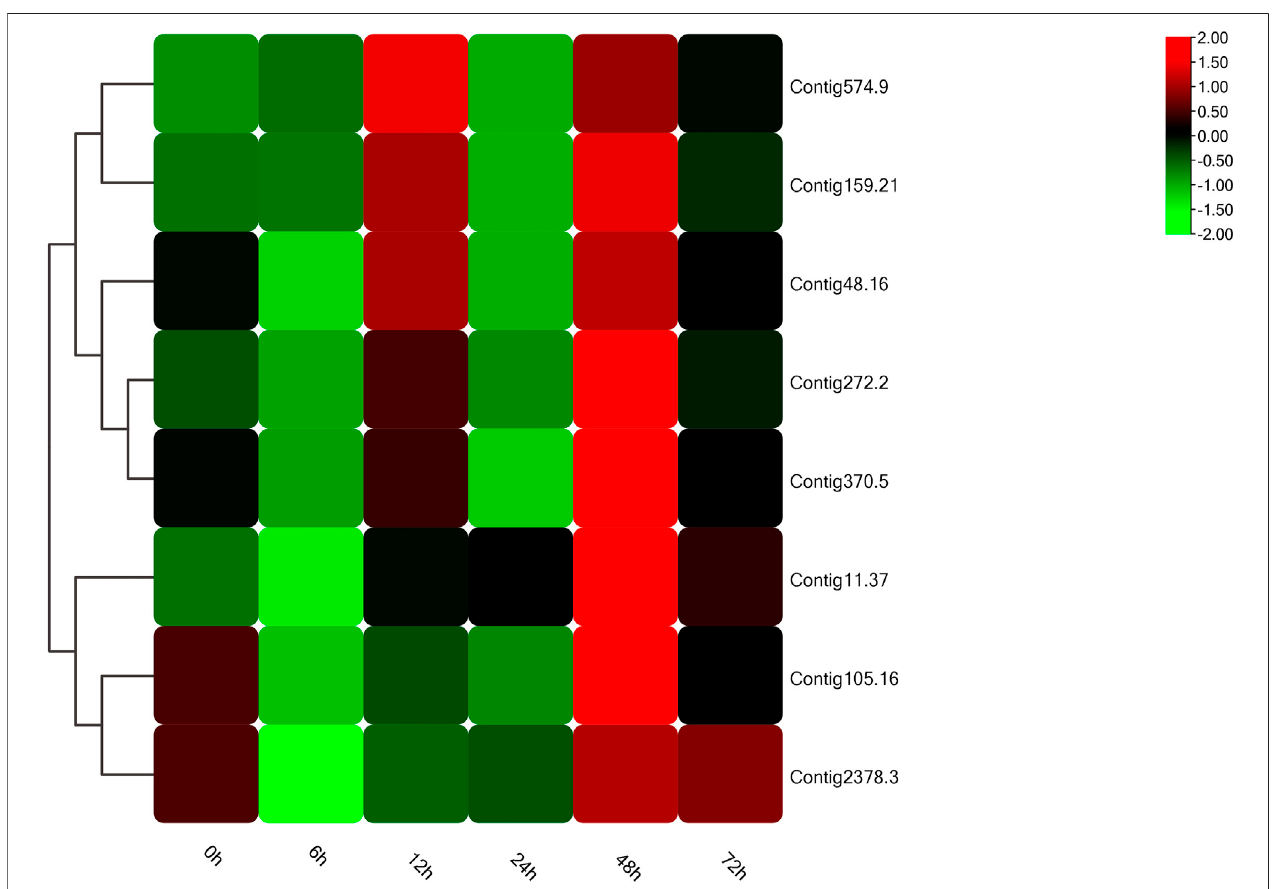
FIGURE 4 | Heat map of salt-tolerant-related